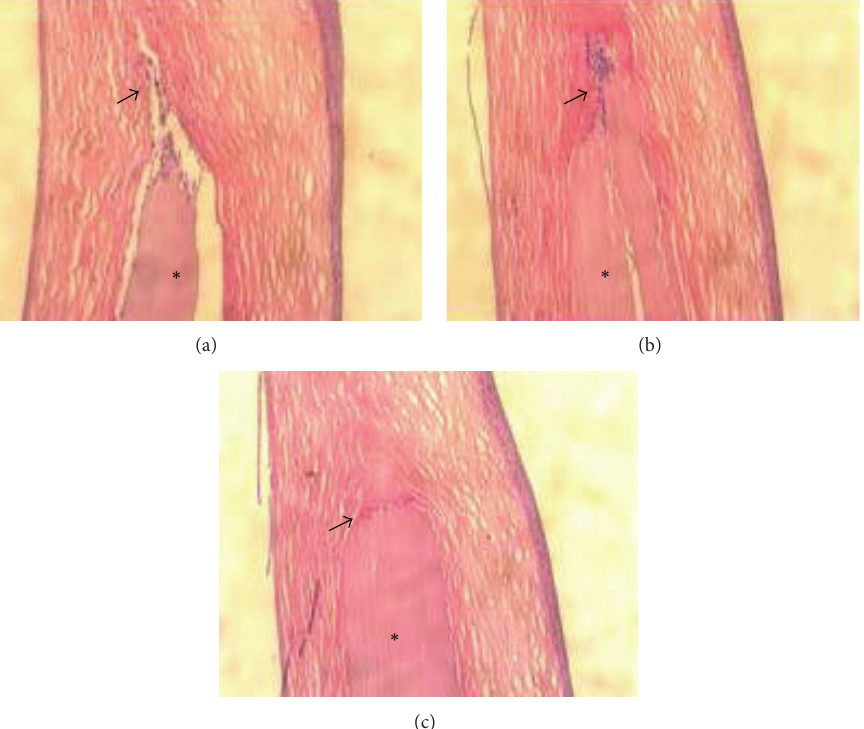
Figure 3: Histology revealed the interface of Biocornea and stromal tissue. Asterisk indicates the location of Biocornea and arrow indicated the immune cells. After 1 week implant, some immune cells infiltrate around the Biocornea and exhibit some space in between tissue and implant (a). There was significant decrease of immune cells and tight junction of implant and tissue after 3 months (b). The implant revealed high biocompatibility from disappearance of immune cells and integration of tissue after 6 months